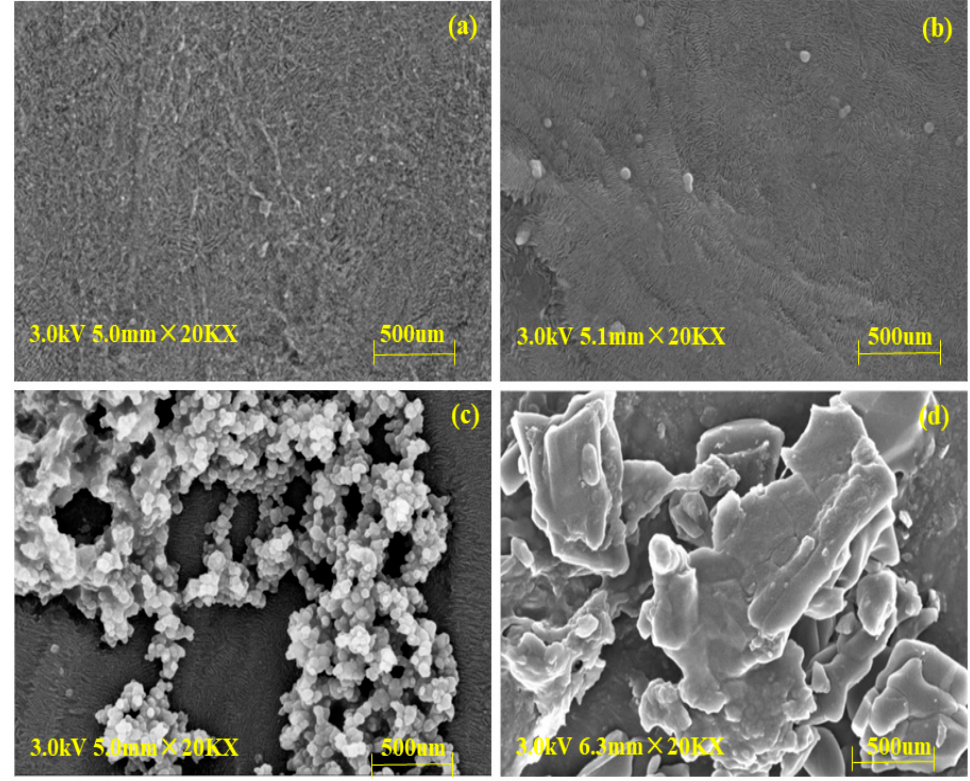
Figure 2. SEM images of BLIMs: ( a ) PES membrane, ( b ) CAL-B@PES, ( c ) CAL-B@PDA/PES, and ( d )